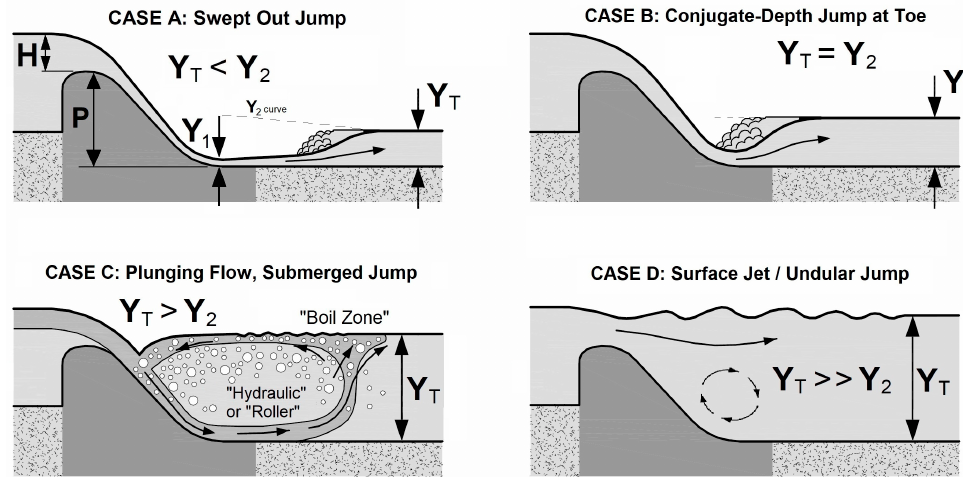
Figure 3. Four possible flow conditions over a low-head dam: Case A—swept-out hydraulic jump; Case B—optimal hydraulic jump; Case C—submerged hydraulic jump; Case D—drowned-out hy- draulic jump (modified from [7]). Each case is illustrated for the default condition of the downstream channel invert matching the toe of the dam, D Z = 0.